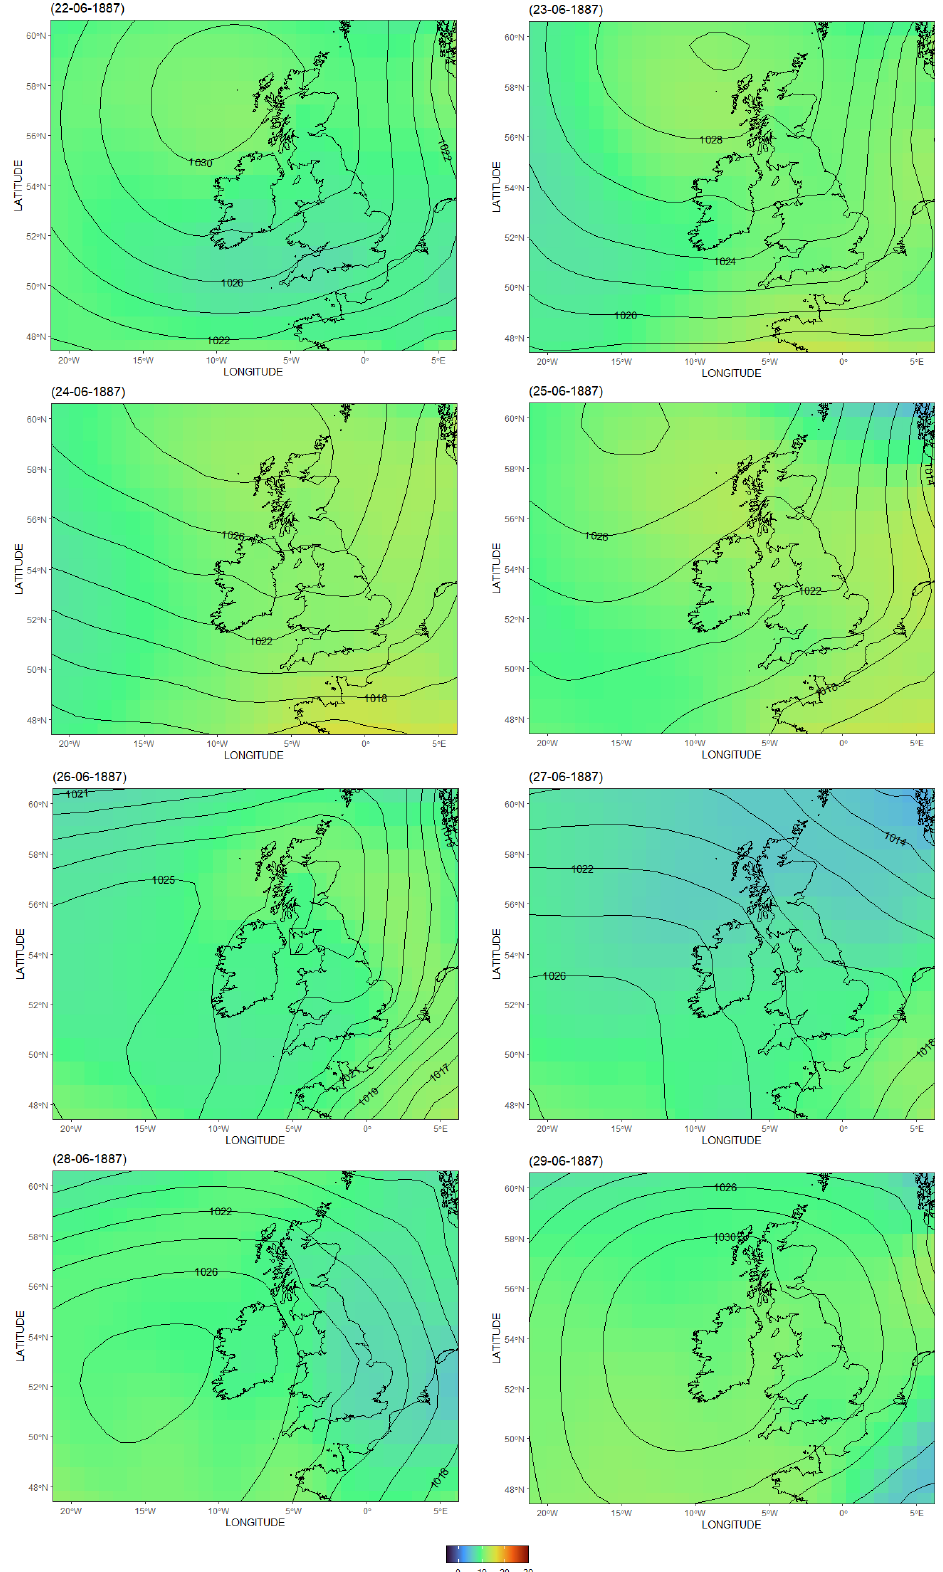
Figure 5. As Fig. 4 but zoomed in to the British and Irish isles region. See the Fig. 4 caption for further details and note that 20CRv3 native resolution is 1 ◦ × 1 ◦